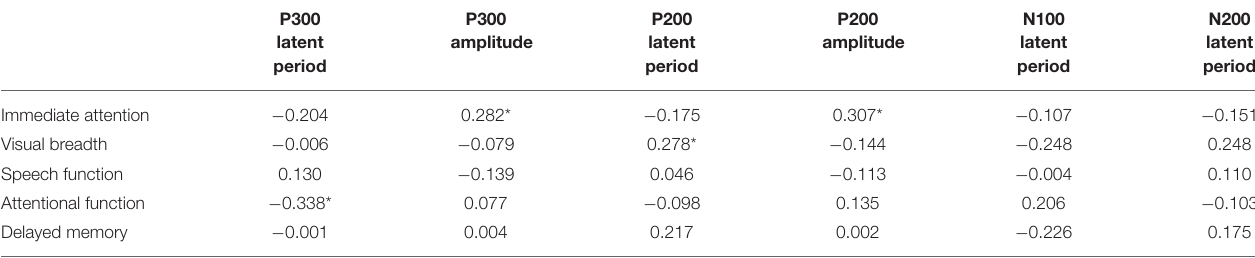
TABLE 6 | Correlation analysis between RBANS scores and ERPs in alcohol-dependence group ( r ).